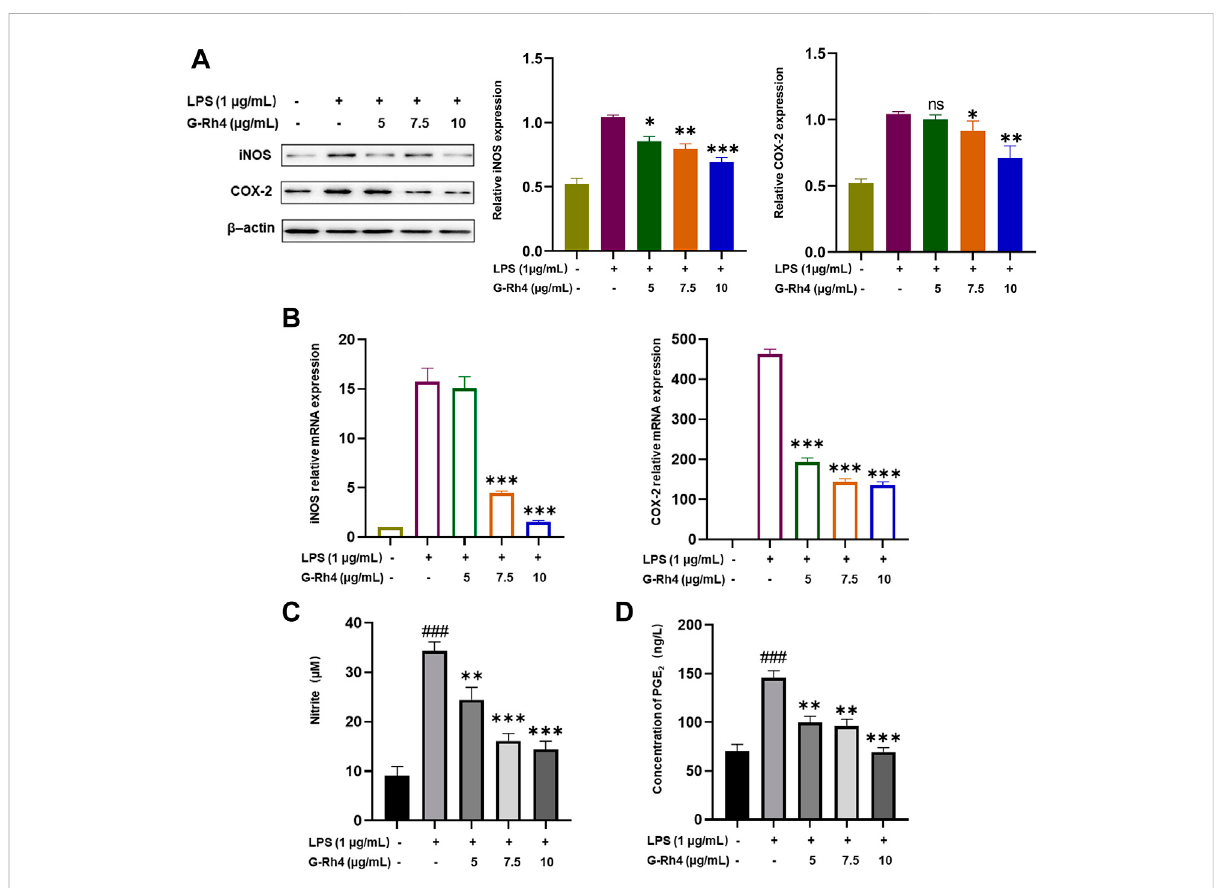
FIGURE 5 Inhibitory effects of G-Rh4 on NO/PGE 2 production and iNOS/COX-2 expression in LPS-stimulated RAW264.7 cells. (A) Effect of G-Rh4 on iNOS and COX-2 protein levels in RAW264.7 cells. (B) Determination of iNOS and COX-2 mRNA levels in LPS-stimulated RAW264.7 cells. (C) NO levels in the culture medium evaluated by Griess reagent. (D) Effect of G-Rh4 on the release of PGE 2 in RAW264.7 cells. Data were presented as the mean ± SD values performed in triplicate ( ## p < 0.01 and ### p < 0.001 vs. control group, * p < 0.05, ** p < 0.01, *** p < 0.001 vs. LPS